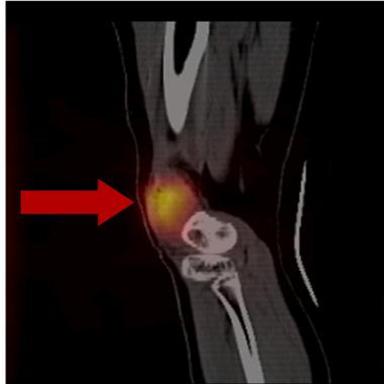
SPECT/CT image of the affected knee joint 1 h after administration of Y-HA.